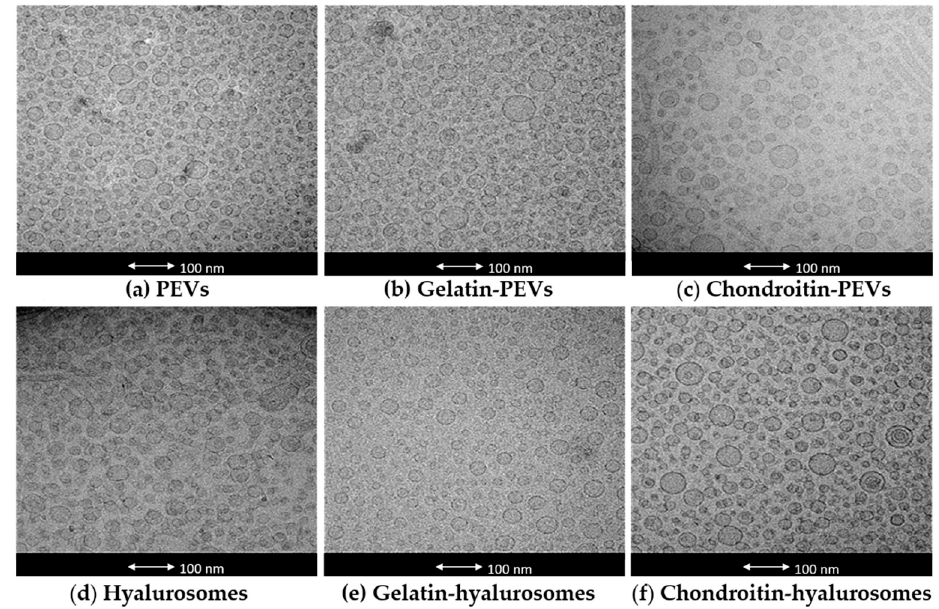
Figure 1. Representative cryo-TEM images of vesicles: ( a ) PEVs; ( b ) gelatin-PEVs; ( c ) chondroitin- PEVs; ( d ) hyalurosomes; ( e ) gelatin-hyalurosomes; ( f ) chondroitin-hyalurosomes.